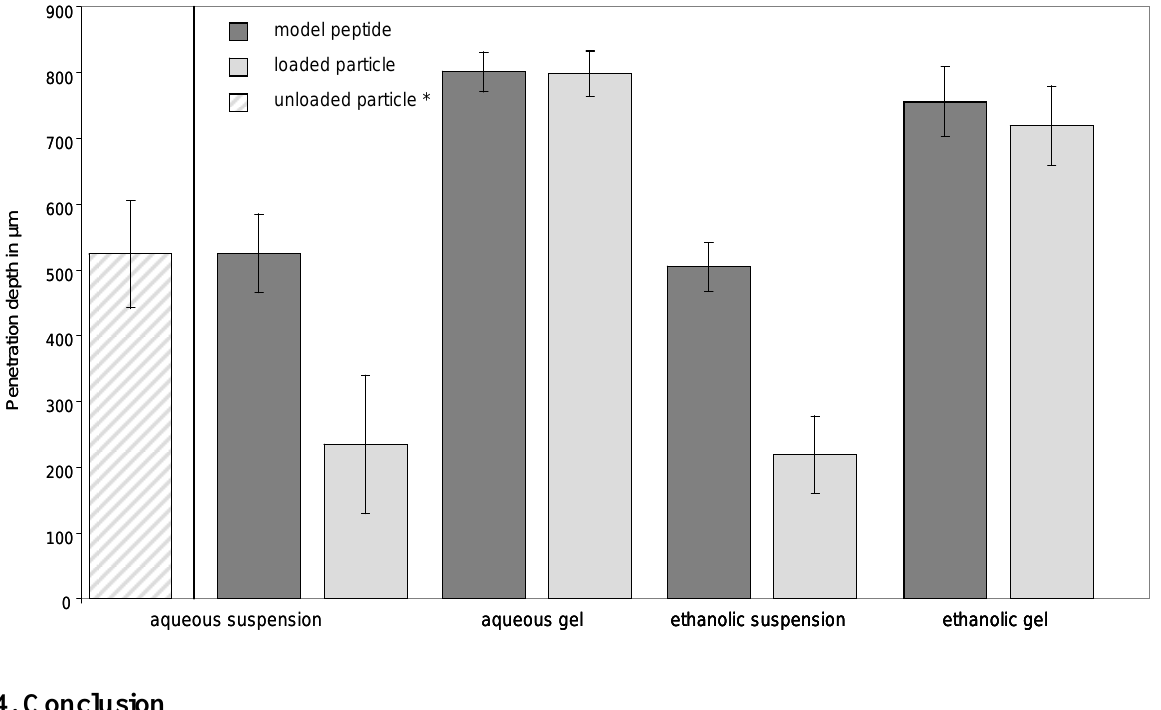
Figure 2. Follicular penetration depths of the loaded particles and the model peptide applied in four different vehicles. (* penetration depth of unloaded bare SiO aqueous suspension for comparison, data utilized from previous study